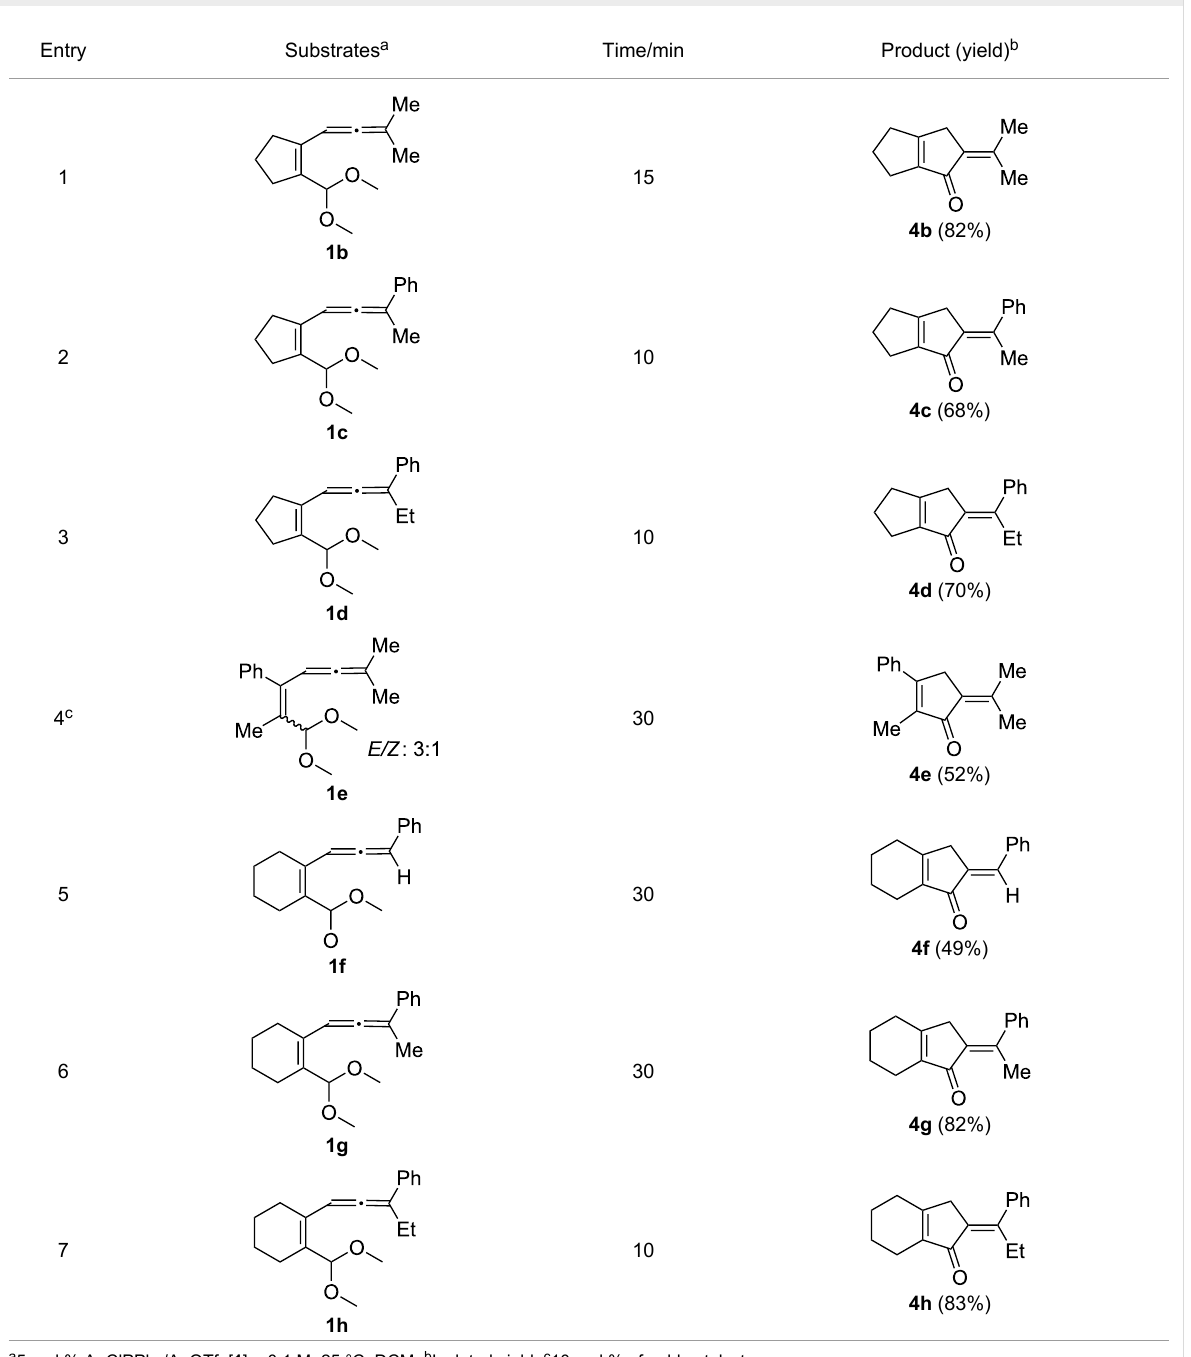
Table 2: Gold-catalyzed cyclization of allenyl